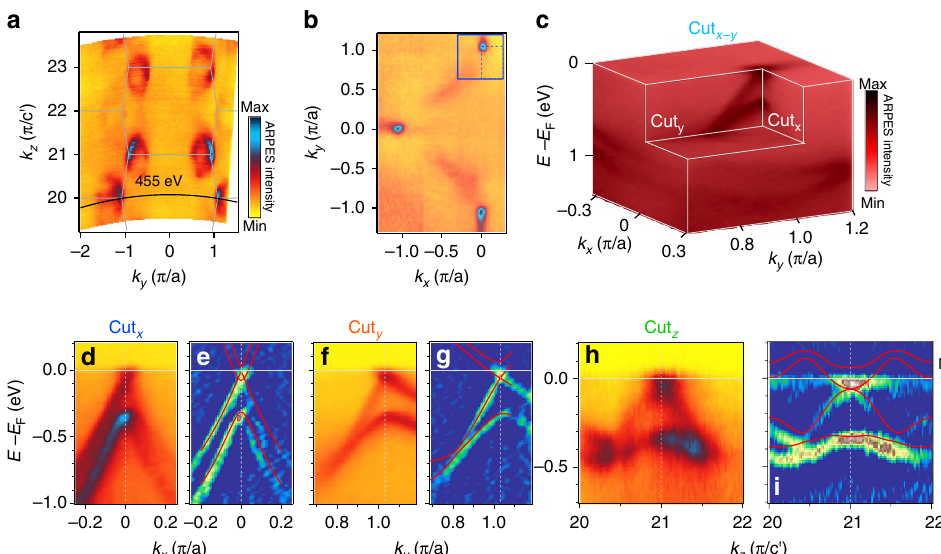
Figure 3 | W2 type of Weyl cones in TaP. ( a ) Fermi surface map in the k y - k z plane at k x ¼ 0, acquired with soft X-ray. ( b ) Fermi surface map in the k x - k y plane at k z ¼ 0, taken with hv ¼ 455eV as indicated in a . ( c ) ARPES intensity profile as a function of energy relative to Fermi level in the k x - k y plane containing a pair of Weyl nodes W2. ( d ) Photoemission intensity plot along cut x passing through W2. ( e ) The corresponding curvature plot of the spectrum in d with the calculated bands overlaid on top for comparison. ( f , g ) and ( h , i ), Same as d , e but along a long cut y and cut z ,